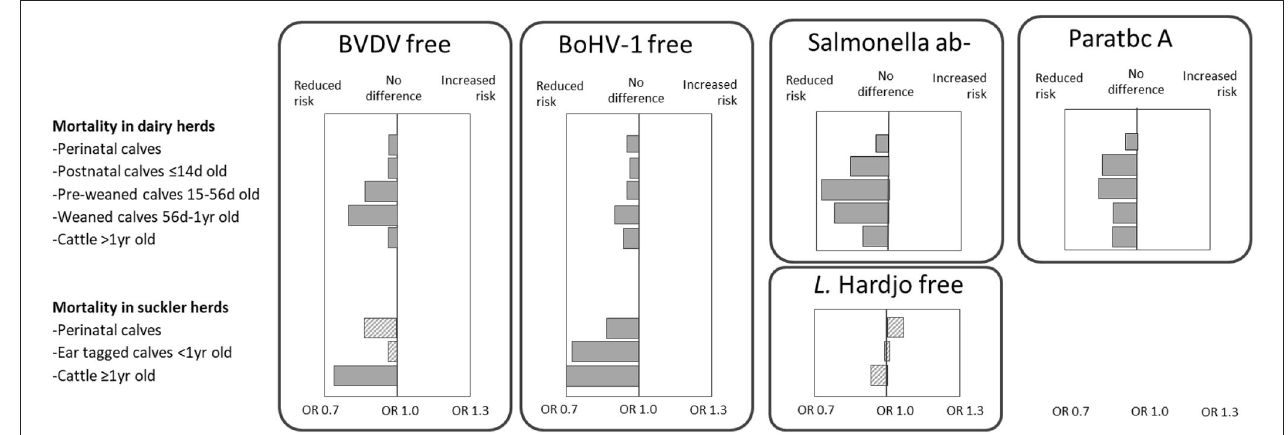
FIGURE 13 | The association between a disease-free status/ antibody negative (ab–)/ status-A (ab–) and mortality in all dairy and all Dutch suckler cow herds in a multivariable population average logistic regression model between 2014 and 2019. Solid boxes represent significant deviations from the Dutch average, and dashed boxes represent non-significant results. Larger boxes represent more extreme odds